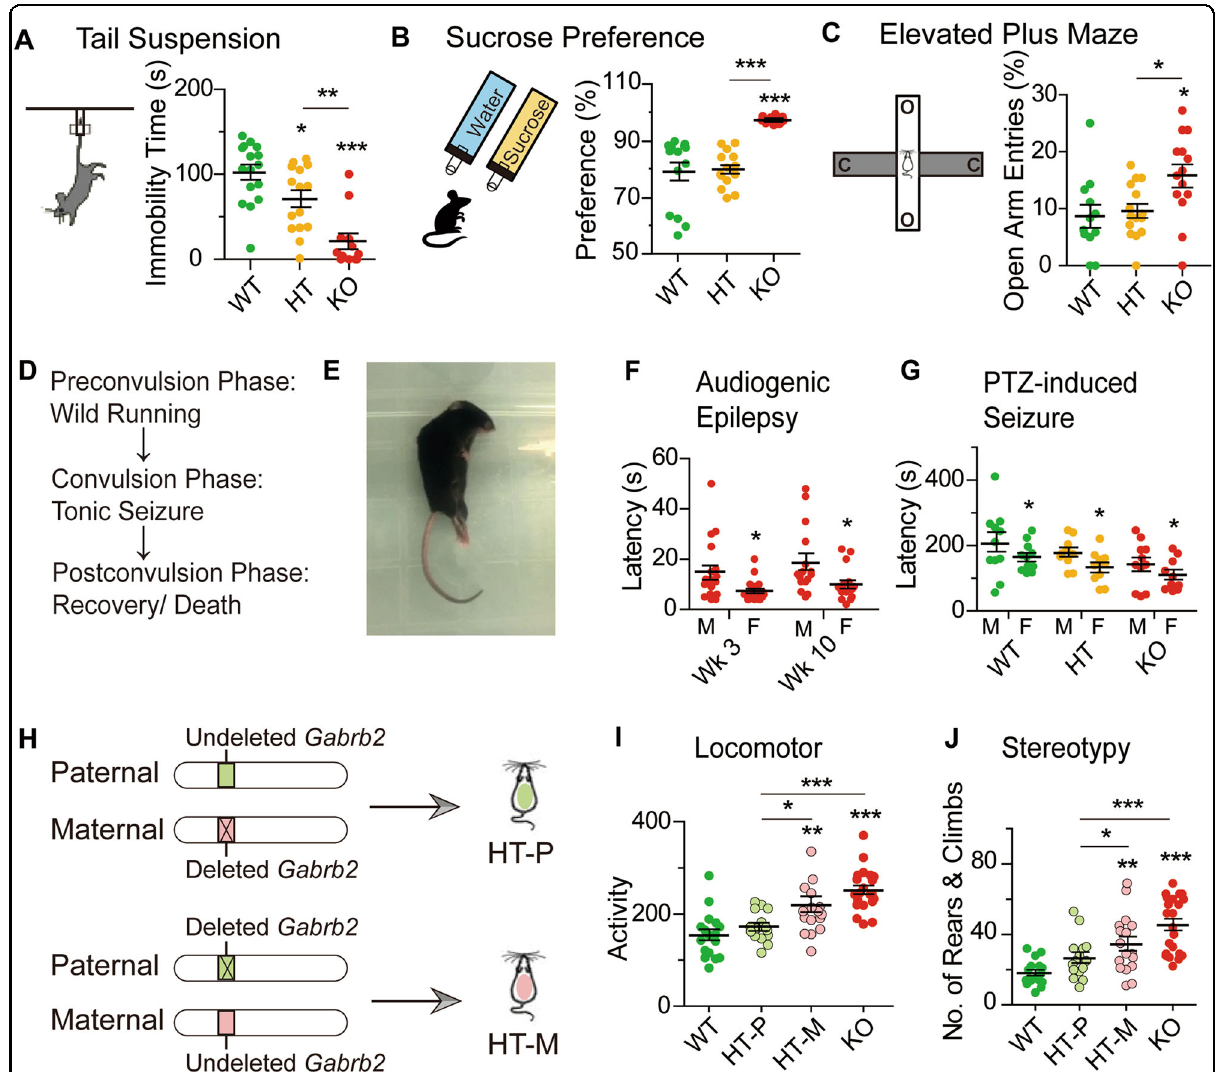
Fig. 1 Epilepsy, affective symptoms, and behavioral genomic imprinting. a Tail-suspension test showing immobility time of mice suspended by the tail to a horizontal bar (WT male n = 16, HT male n = 15, KO male n = 12). b Sucrose-preference test showing preference in terms of sucrose solution consumed as percentage of total liquid consumption (WT male n = 14, HT male n = 15, KO male n = 12). c Elevated-plus maze test showing percentile entries into open arms (WT male n = 12, HT male n = 15, KO male n = 14). In schematic of ( c) , O represents open arm and C represents closed arm. d Schematic of the different phases in audiogenic epilepsy. e KO mouse undergoing tonic seizure. f Audiogenic epilepsy: signi fi cant effect of gender on latency of audiogenic epilepsy was displayed by the mice ( F 1,65 = 12.12, p < 0.01; week-3 KO male n = 18, female n = 19; week-10 KO male n = 16, female n = 16). g PTZ-induced seizure: signi fi cant effects of gender ( F 1,57 = 6.12, p < 0.05) and genotype ( F 2,57 = 4.71, p < 0.05) on the latency of PTZ-induced seizure were displayed by the mice (WT male n = 11, female n = 11; HT male n = 10, female n = 10; KO male n = 11, female n = 10). In both parts ( f) and (g) , male and female mice are labeled M and F, respectively; and data were analyzed using two-way ANOVA with Dunnett ’ s post-hoc test. h Schematic representation of two types of HT hemizygosity differing in parental origin of undeleted copy of Gabrb2 . Upper: HT-P mouse displayed the phenotype of the Gabrb2 of paternal origin (light green) while the maternal copy (pink) had been deleted. Lower: HT-M mouse displayed the phenotype of the Gabrb2 of maternal origin (pink) while the paternal copy (light green) had been deleted. i Imprinting effect on locomotor activity (WT male n = 17, HT-P male n = 15, HT-M male n = 17, KO male n = 22). j Imprinting effect on behavioral stereotypy (WT male n = 17, HT-P male n = 15, HT-M male n = 17, KO male n = 22). Except for the epilepsy tests ( f , g ), statistical analysis was performed using one-way ANOVA with Newman – Keuls post-hoc test. WT mice are represented by green dots; HT by orange dots; HT-P by light green dots; HT-M by pink dots; and KO by red dots. Average y values ± SEM in the different plots are represented by horizontal bars. * p < 0.05, ** p < 0.01, *** p <